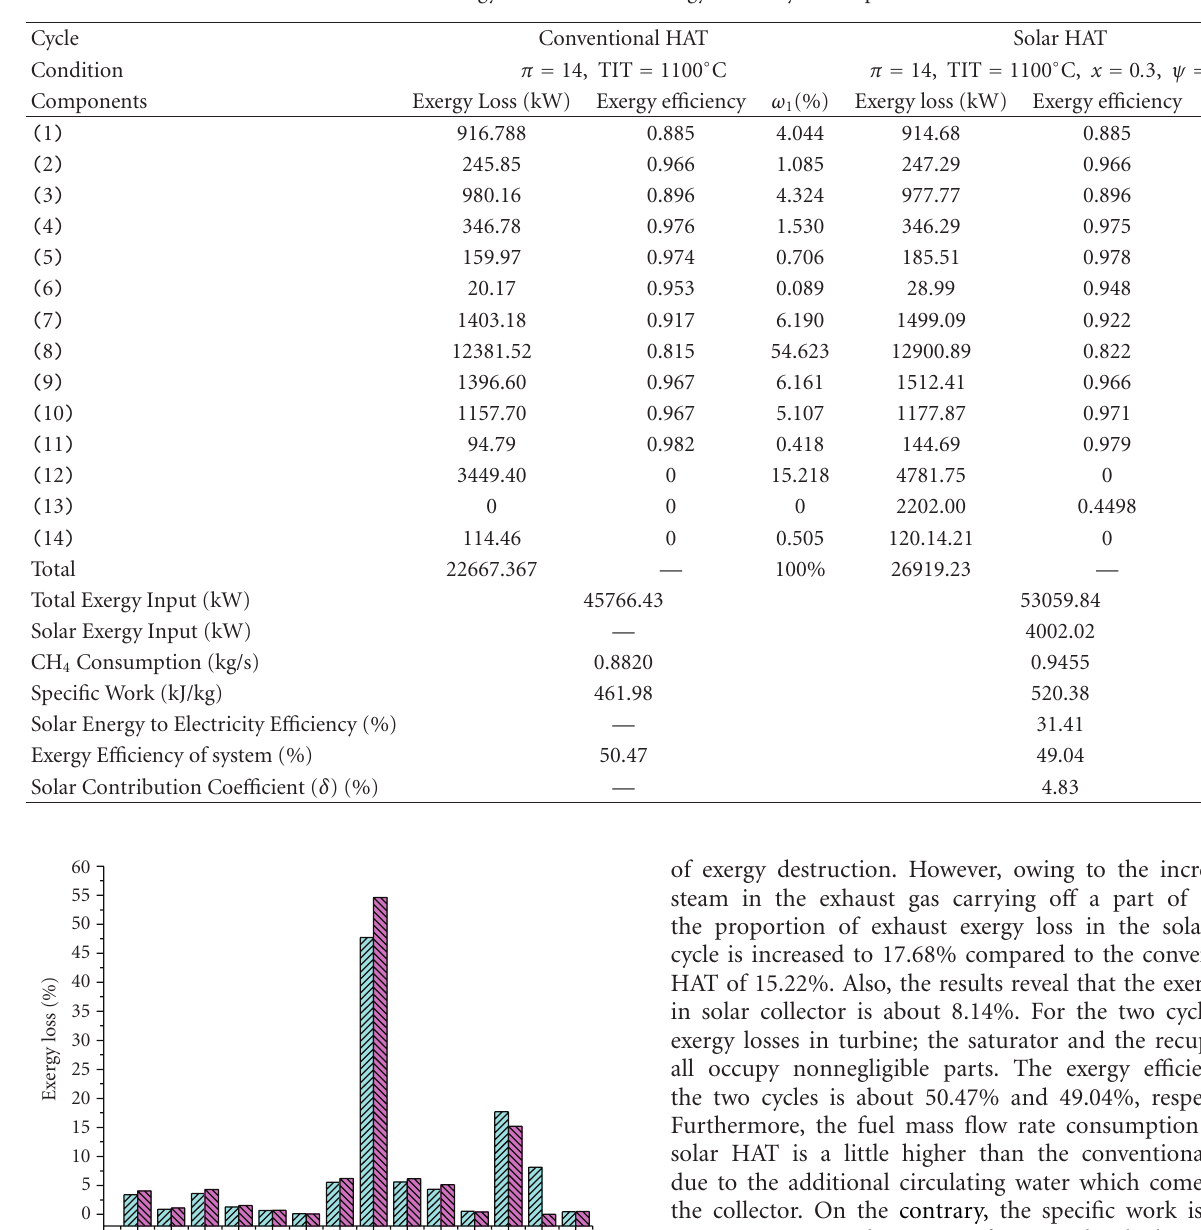
Table 3: Exergy destruction and exergy e ffi ciency of components.